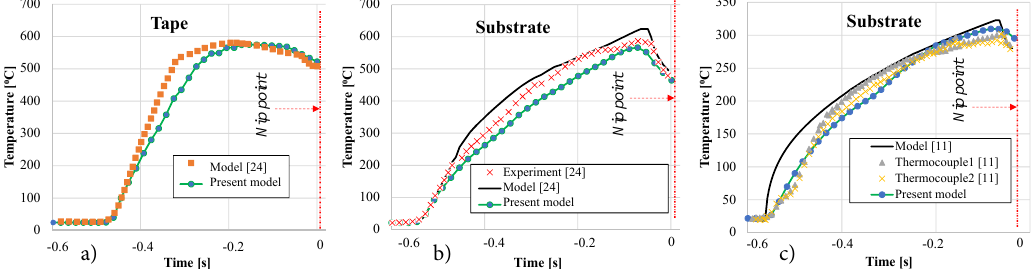
Figure 9. Tape ( a ) and substrate ( b , c ) temperature results from Reference [11,24] and corresponding results from the developed present simulation model. The temperature of a particle through the time from laser irradiation until nip point is